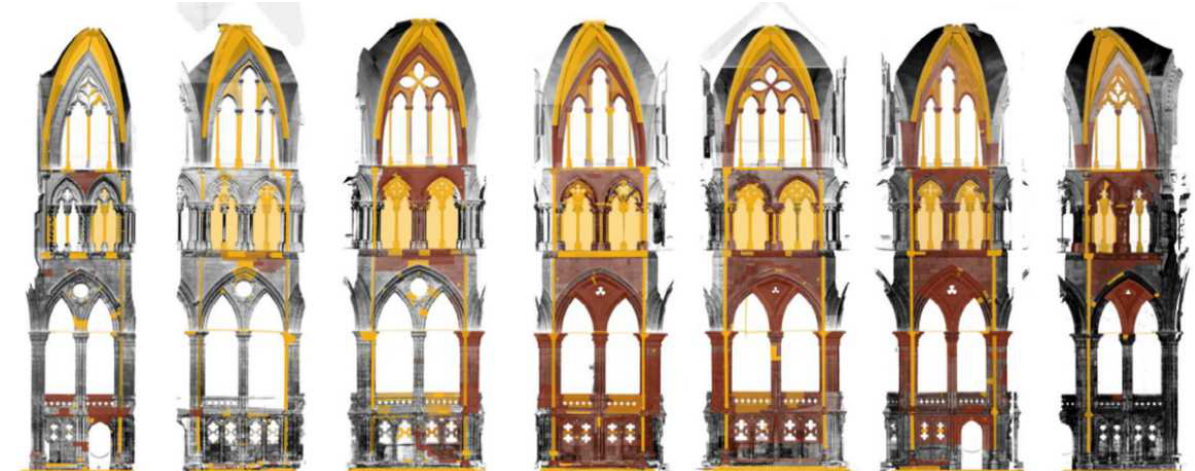
Figure 9. Inner elevation development of the bays NW, N, NO, O, SO, S, SW, except western Screen Wall (clockwise), with all the restoration measures detected through this research (in red-colours the ones from Valkendorff’s period and in yellow the ones of Christie’s).